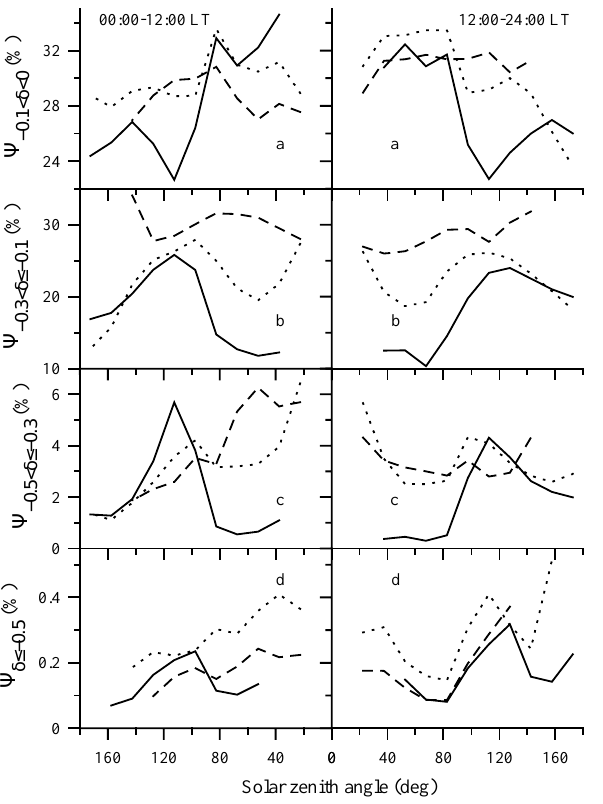
369 5 < 0 . Ψ − Solar zenith angle (deg) Fig. 8 Fig. 9 Fig. 8. The dependence of the Nm F2 negative disturbance proba- Fig. 9. The dependence of the Nm F2 negative disturbance proba- bility functions on the solar zenith angle in latitude range 3 (30 ◦ < bility functions on the solar zenith angle in latitude range 4 (45 ◦ < | ϕ | ≤ 45 ◦ , 30 ◦ < | 8 | ≤ 45 ◦ ) during the winter (solid lines), sum- | ϕ | ≤ 60 ◦ , 45 ◦ < | 8 | ≤ 60 ◦ ) during the winter (solid lines), sum- mer (dashed lines), and spring and autumn (dotted lines) months for mer (dashed lines), and spring and autumn (dotted lines) months for the weak (panels a), normal (panels b), strong (panels c), and very the weak (panels a), normal (panels b), strong (panels c), and very strong (panels d) Nm F2 negative disturbances. The 0 ◦ − 180 ◦ solar strong (panels d) Nm F2 negative disturbances. The 0 ◦ − 180 ◦ solar zenith angle range includes the local time period from 00:00LT to zenith angle range includes the local time period from 00:00LT to 12:00LT (left panels) and from 12:00LT to 24:00LT (right panels). 12:00LT (left panels) and from 12:00LT to 24:00LT (right panels). to latitude ranges 3–5, where < 9 − 0 . 1 <δ< 0 (χ) > 1 is less than < 9 − 0 . 1 <δ< 0 (χ) > 2 in latitude ranges 1 and 2 for all seasons, except for latitude range 2 for spring and autumn